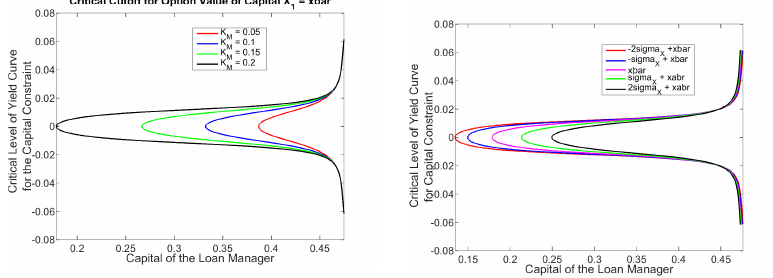
Figure 8. Critical Cut off ρ κ , (67), such that Capital Constraint Binds,